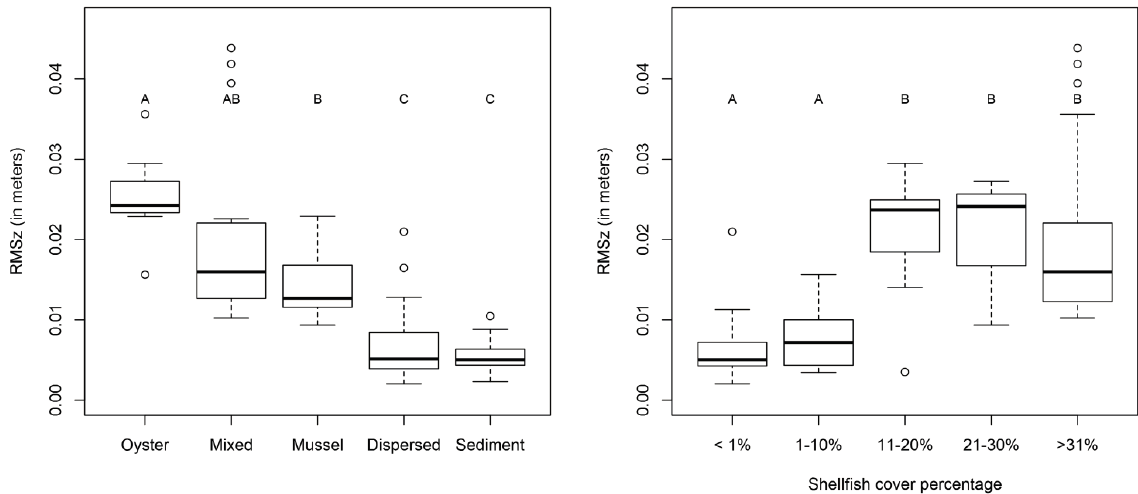
Figure 3. ( Left ) RMSz for oyster, mixed, mussel, dispersed and sediment plots (shellfish classes significantly different from dispersed and sediment at p < 0.05); ( Right ) RMSz as a function of shellfish cover: RMSz in cover classes < 1% and 1%–10% significantly differed from that in classes 11%–20%, 21%–30% and >21% ( p < 0.05). Letters indicate homogeneous groups based on the Tukey HSD test. In the boxplots, the rectangles of the boxes show the interquartile range, the bold bar the median and the whiskers the minimum and maximum values (without